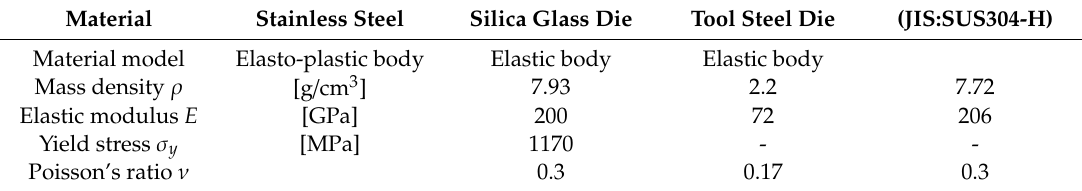
Figure 3. Schematic illustration of the finite element (FE) model for the contact state analysis of bending with the ironing process. Table 3. Analytical conditions of material models for the contact state analysis.